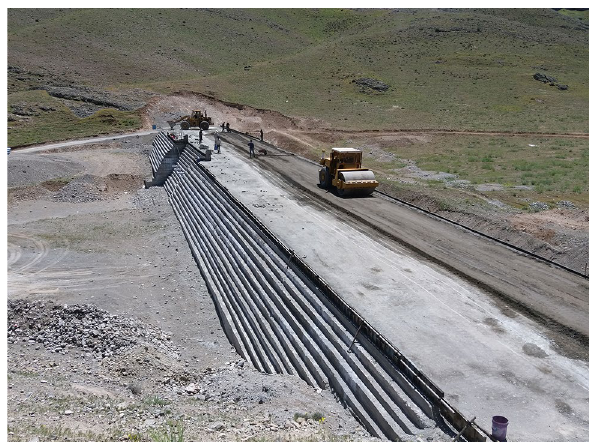
Fig. 2 The CSG check dam in the Marand city of Iran during con- struction